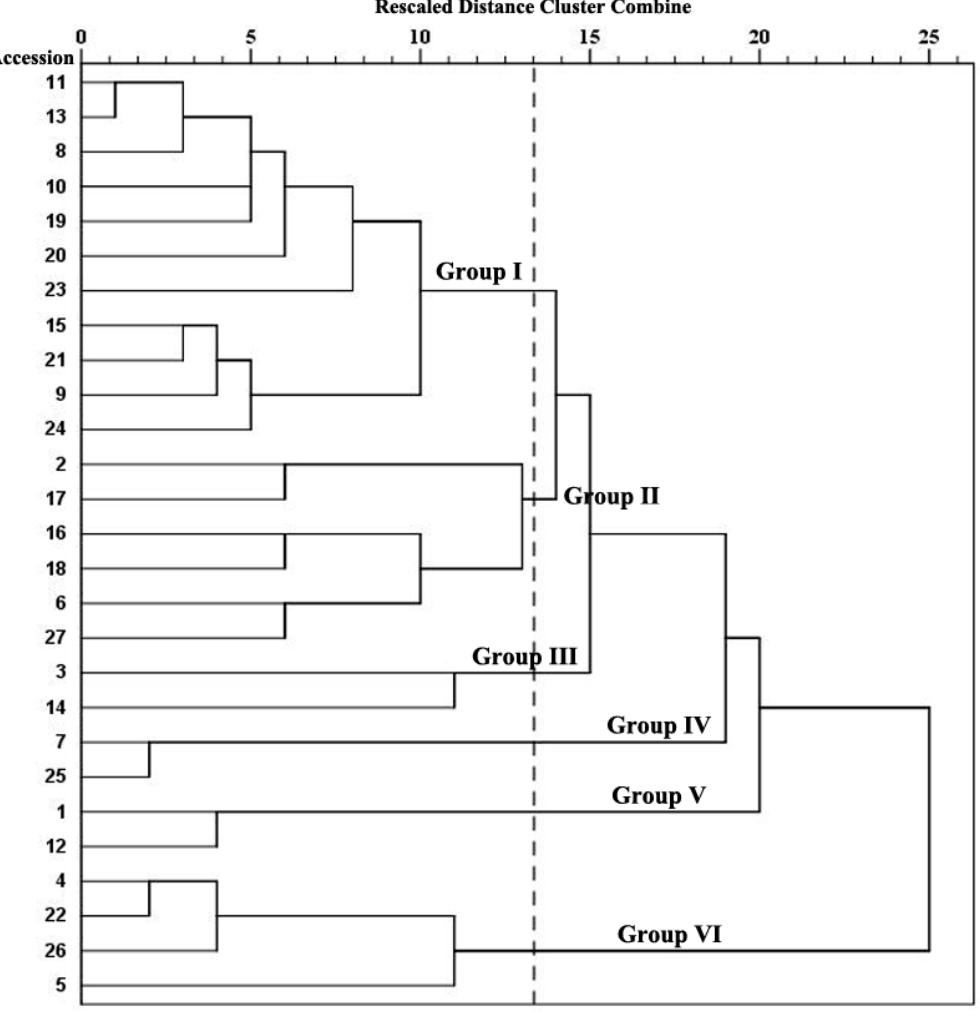
Figure 3. Hierarchical cluster dendrogram of twenty-seven bearded iris accessions.